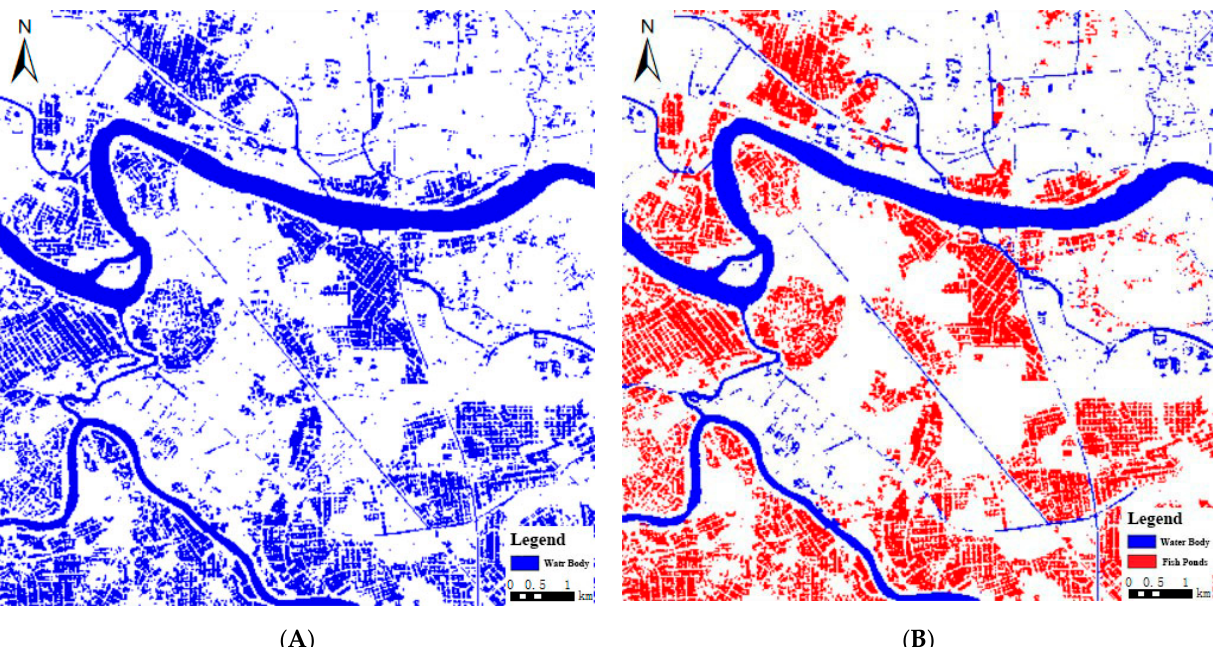
Figure 13. Image classification results and the subsequent visual interpretation results: ( A ) the classification results using SVM; ( B ) the results of visual interpretation. Table 2. Error Matrix of Classification Accuracy Assessment for Each Yearly Result.